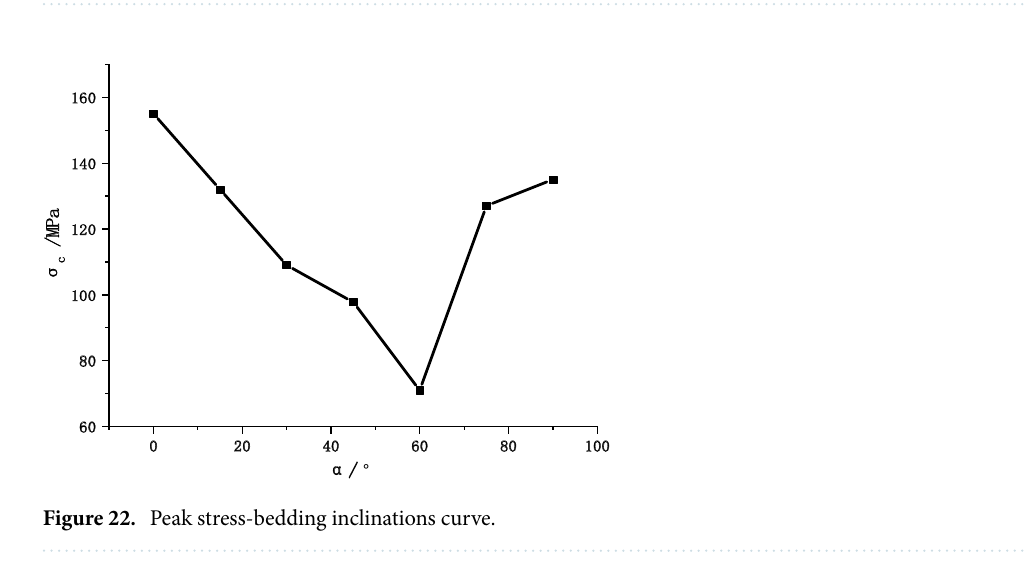
Joint inclinations